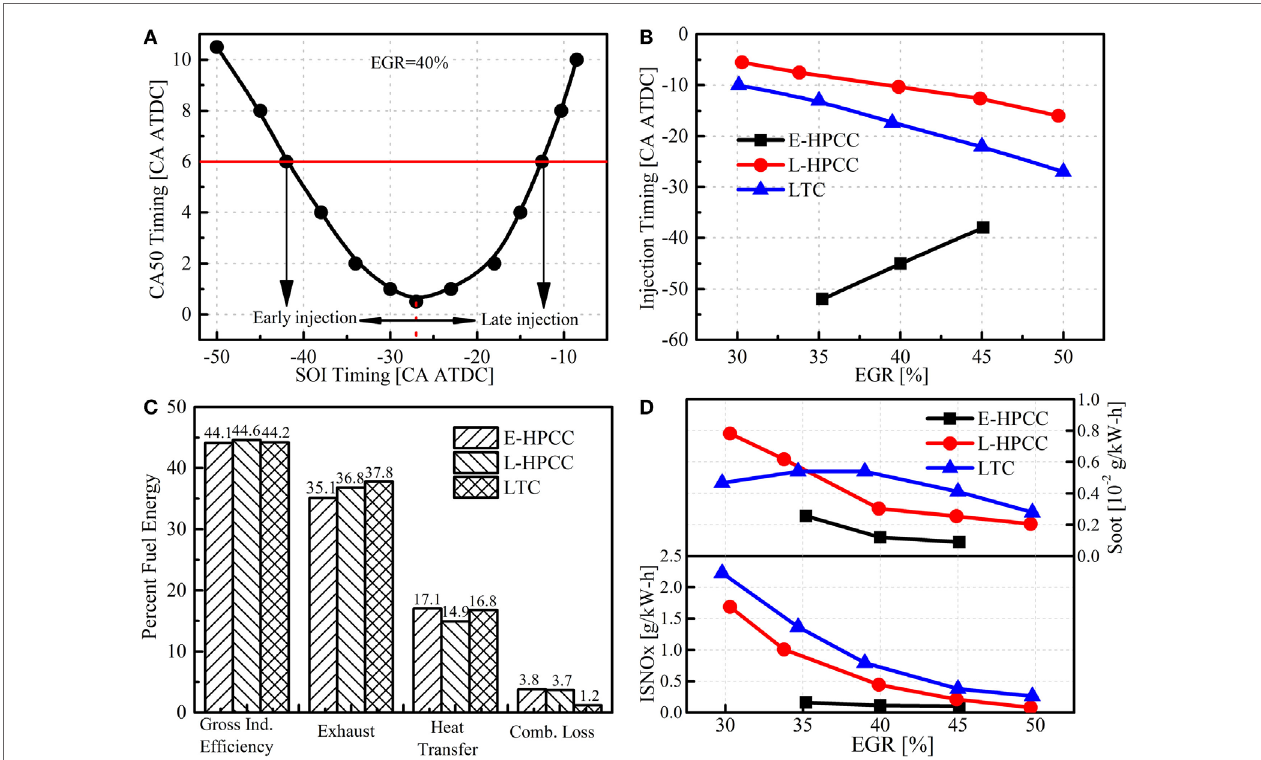
FiGURe 8 | effect of SOi timing on CA50 timing in HPCC combustion (A), the required SOi timing as a function of eGR rate to keep CA50 at 8.0° ATDC for the three combustion modes (B), the comparisons of energy flow analysis (C), and soot and NOx emissions (D) among LTC, L-HPCC, and e-HPCC modes